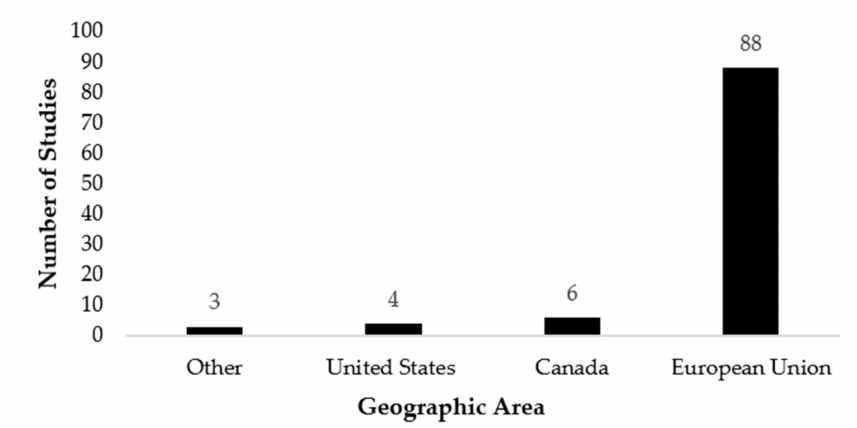
Figure 2. The geographic area of where each study included in the scoping review was conducted. For studies not listing a country of origin, the first author’s affiliations were used as study